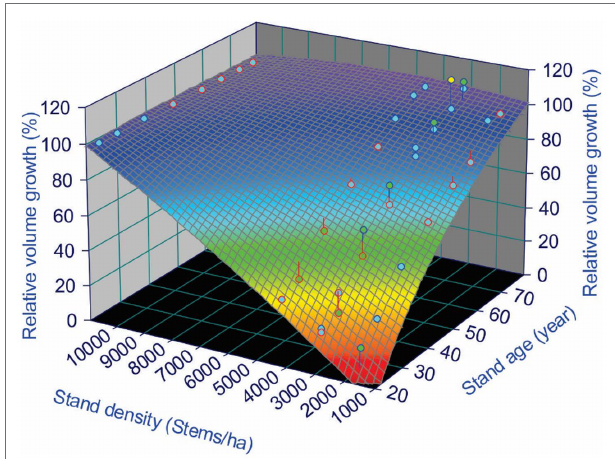
FIGURE 2 | Compensatory growth (CG) of lodgepole pine ( Pinus contorta Douglas) in Block A of the MacKay thinning trial in Alberta, Canada, expressed as relative volume growth under different stand densities over a 60-year experimental period. Maximum relative volume growth was calculated as the ratio of the volume obtained in the treated vs. control stands (see Eq.